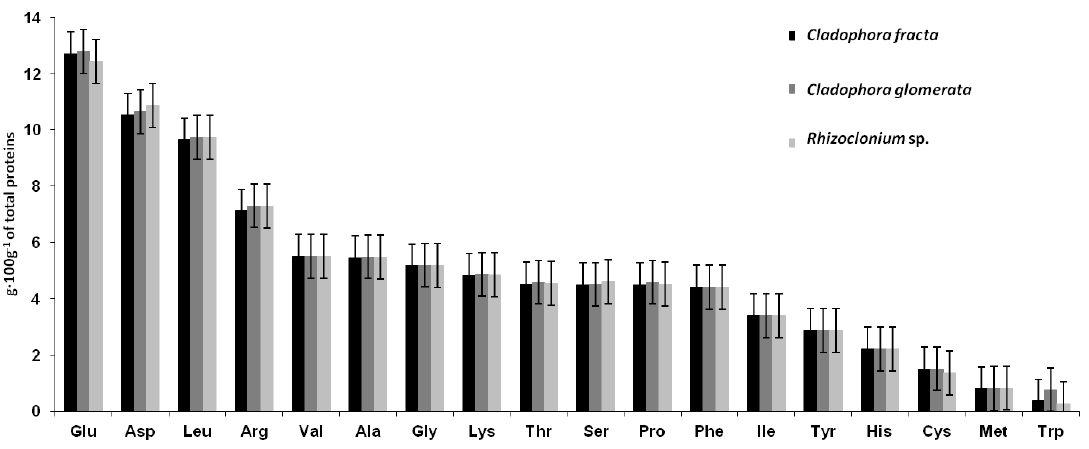
Figure 2: Amino acid profile in study algae (g·100g -1 of total